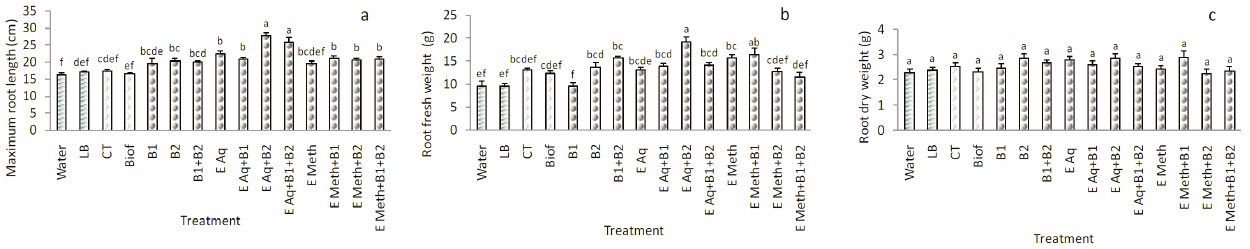
Fig. 2 ­ Comparative efficacy of single and combined bio­treatments with Sargassum vulgare extracts and selected Bacillus spp. strains on the root development of eggplant plants compared to the untreated control and to two organic amendments. Water= Plants treated with water; LB= Plants treated with Luria­Bertani broth medium; CT= Plants treated with a compost tea; Biof= Plants treated with a commercial bio­fertilizer (Acadian™); B1= Single treatment with B. subtilis SV41; B2= Single treatment with B. amyloliquefaciens subsp. plantarum SV65; B1+B2= Combined treatment with B. subtilis SV41 and B. amyloliquefaciens subsp. plantarum SV65; E Aq= Single treatment with aqueous S. vulgare extract; E Aq+B1= Combined treatment with S. vulgare aqueous extract and B. subtilis SV41; E Aq+B2= Combined treatment with aqueous S. vulgare extract and B. amyloliquefaciens subsp. plan‐ tarum SV65; E Aq+B1+B2= Combined treatment with aqueous S. vulgare extract and both Bacillus spp. strains. E Meth= Single treatment with methanolic S. vulgare extract. E Meth+B1= Combined treatment with methanolic S. vulgare extract and B. subtilis SV41; E Meth+B2= Combined treatment with methanolic S. vulgare extract and B. amyloliquefaciens subsp. plantarum SV65; E Meth+B1+B2= Combined treatment with methanolic S. vulgare extract and both Bacillus spp. strains. Bars sharing the same let­ ters are not significantly different according to Multiple Range Duncan test at 5%. (a) Comparative efficacy of tested bio­treat­ ments on eggplant maximum root length; (b) Comparative efficacy of tested bio­treatments on eggplant root fresh weight; (c) Comparative efficacy of tested bio­treatments on eggplant root dry weight.